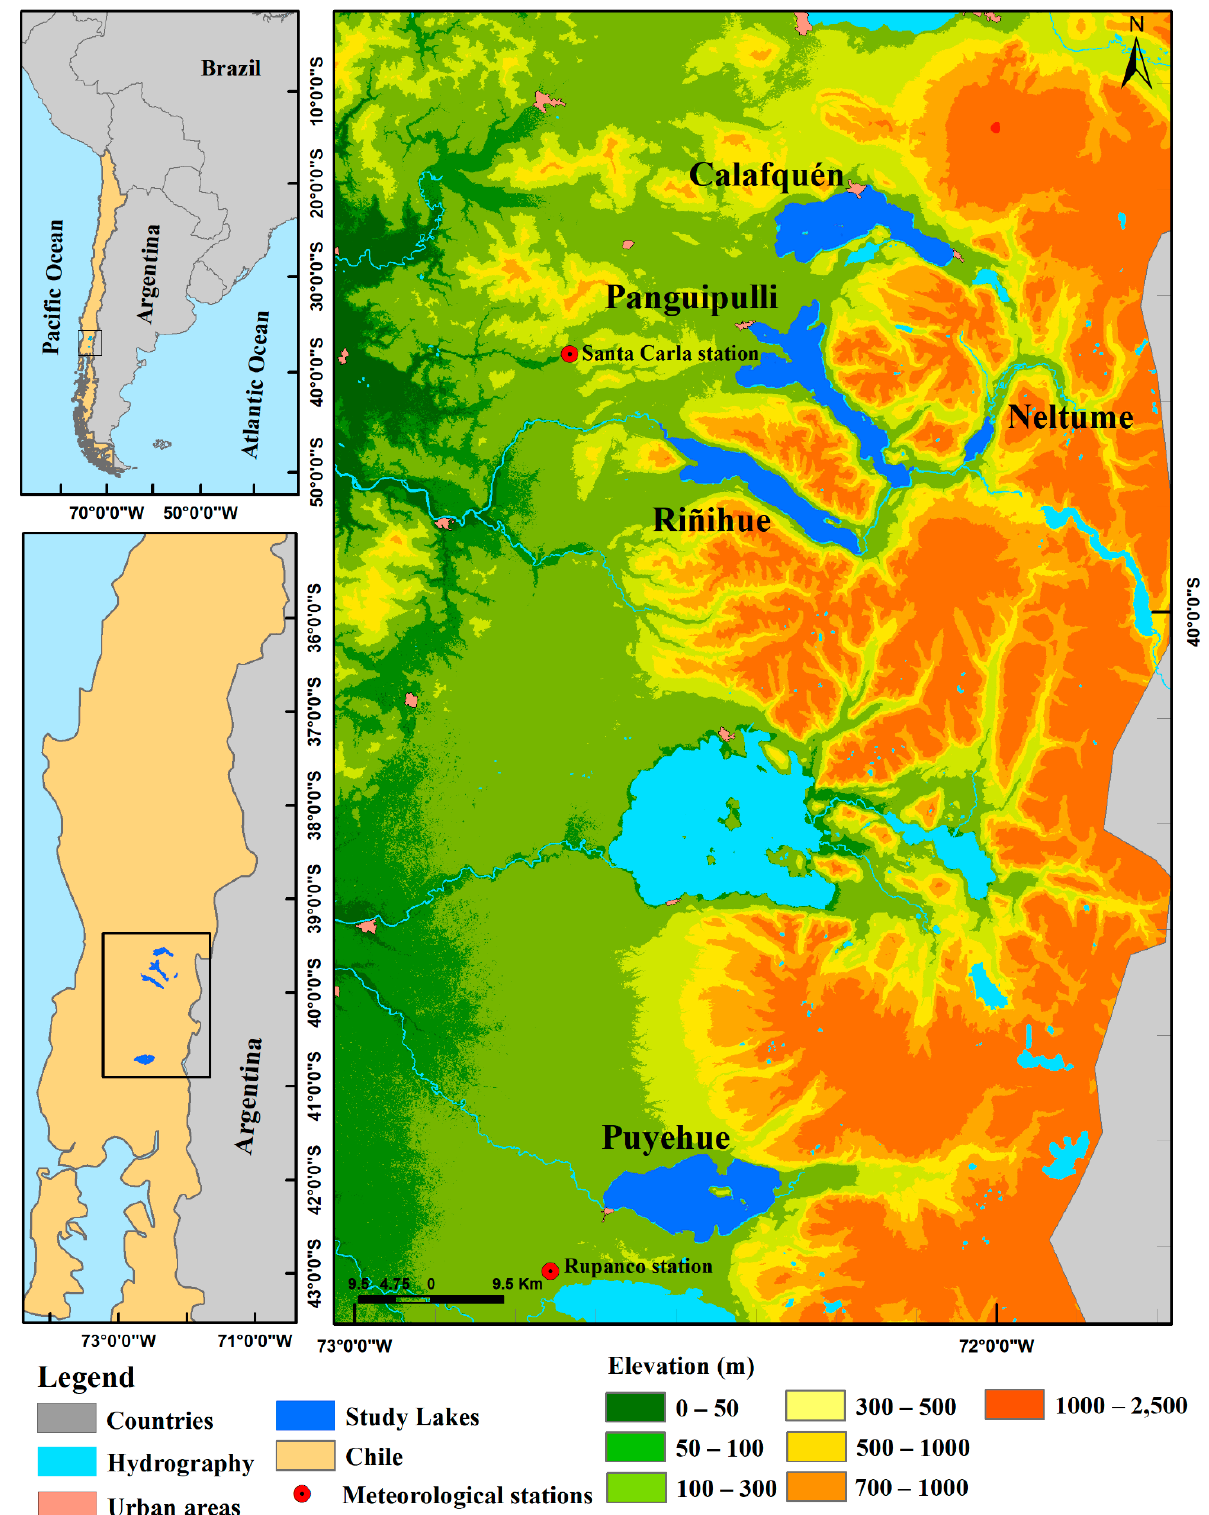
Figure 1. Study area. Lakes under study, in order from the north to south: Calafquén, Neltume, Riñihue, Panguipulli and Puyehue.